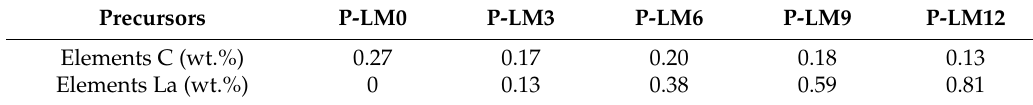
Table 3. Content of C and La element in each MoO 2